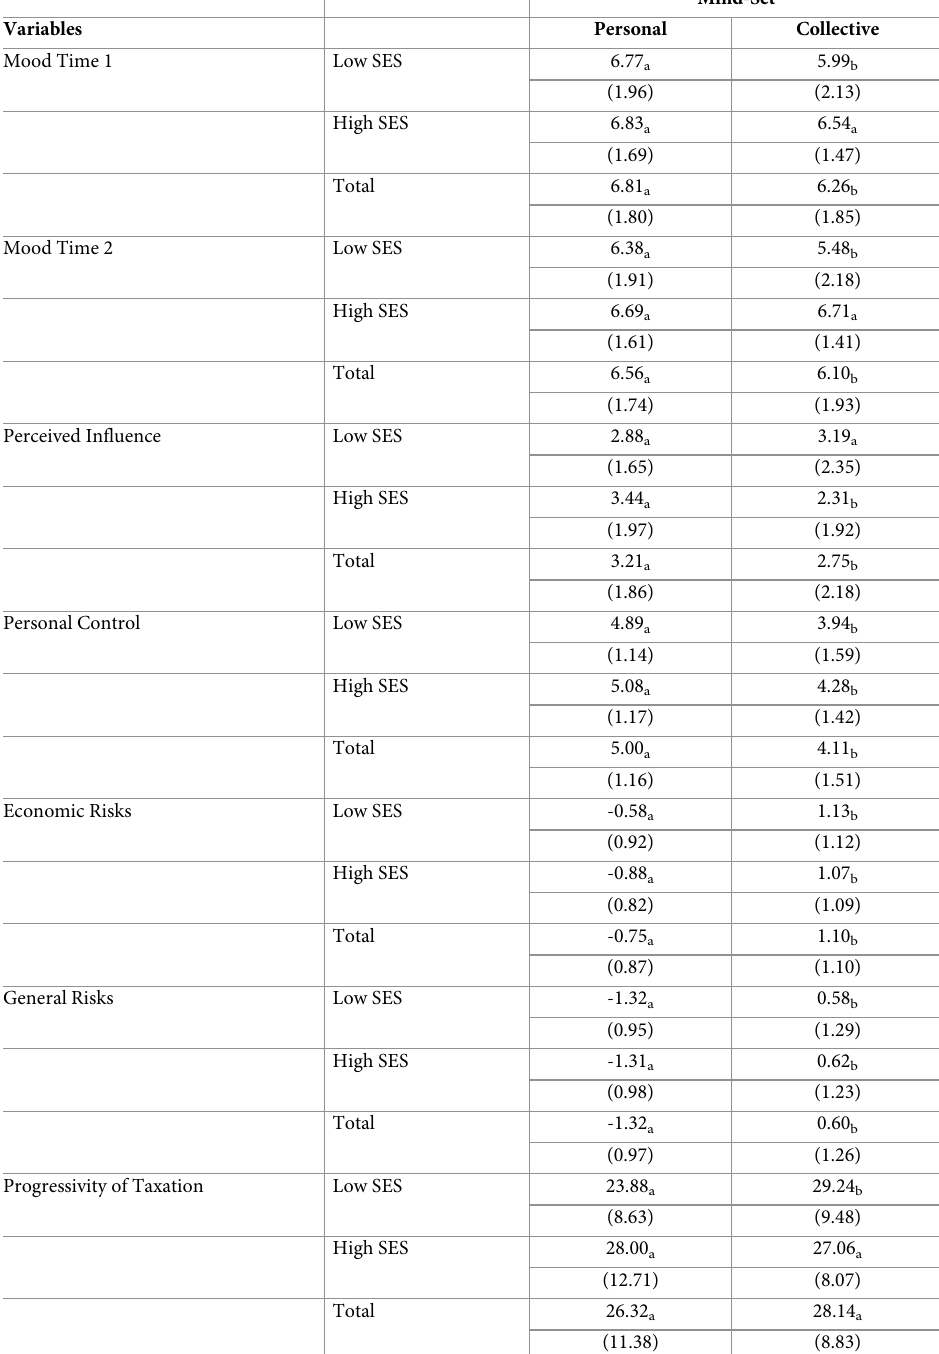
Table 2. Study 1 ( N = 306). Means and standard deviations of Mood Time 1, Mood Time 2, Perceived Influence, Per- sonal Control, Economic Risks, General Risks, and Progressivity of Taxation as a function of Manipulated